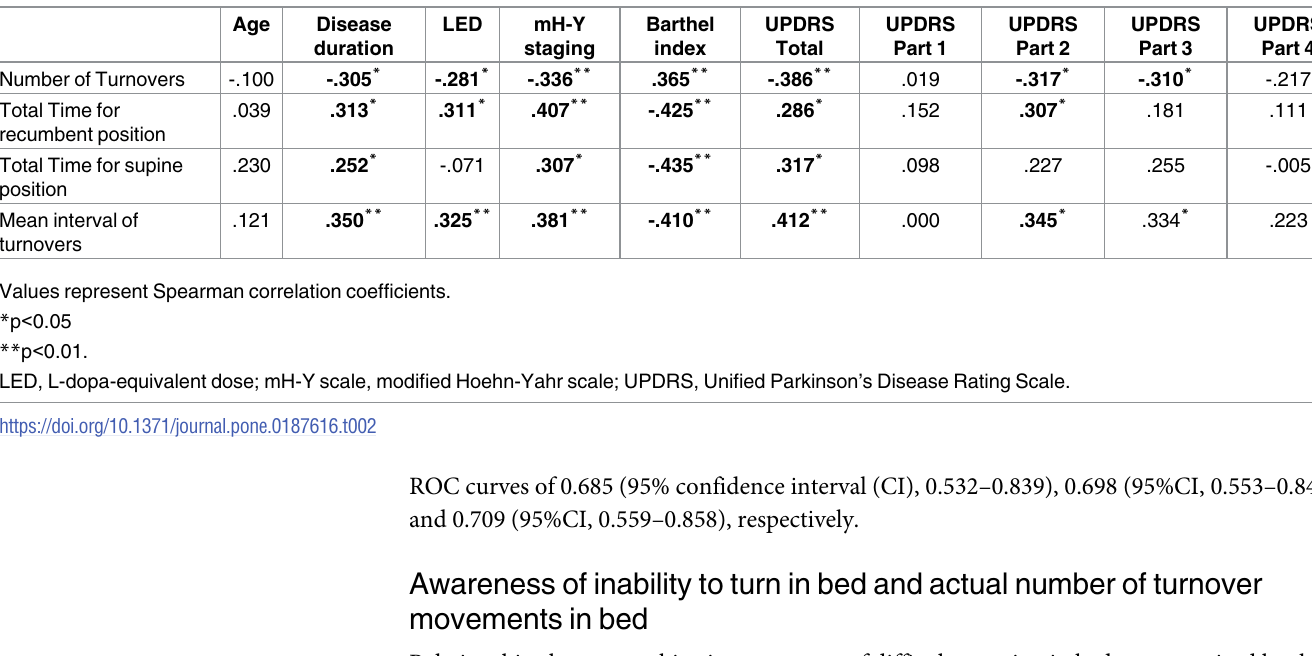
Awareness of inability to turn in bed and actual number of turnover movements in bed Relationships between subjective awareness of difficulty turning in bed as categorized by the PDSS-2 item 9 and nocturnal kinetic parameters are shown in Table 3. Although PD patients with a higher score for PDSS-2 item 9 tended to show longer total time recumbent and longer